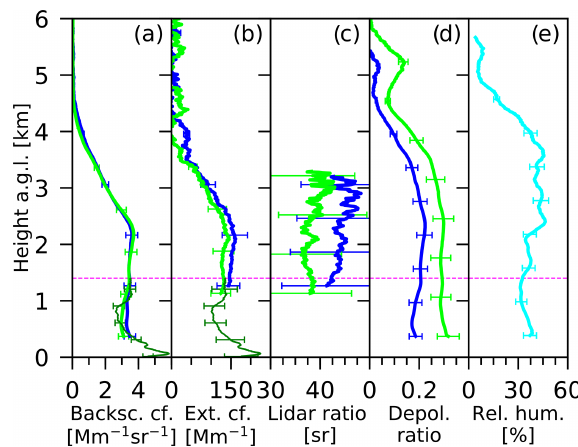
Figure 6. Overview of the basic lidar products obtained from the Dushanbe lidar observations. The Polly measurement was taken on 28 June 2016, 18:00–20:59UTC: (a) particle backscatter coefficient at 355nm (blue, 743m vertical smoothing length) and 532nm (dark green, 23m vertical smoothing, green, 743m vertical smoothing); (b) particle extinction coefficient at 355 (blue) and 532nm (green), 743m vertical smoothing, and 532nm particle extinction coefficient (dark green) calculated from the 532nm particle backscatter coeffi- cient (dark green in b ) and the 532nm lidar ratio at 1.4km (magenta dashed line indicates the 1.4km height); (c) lidar ratio at 355 (blue) and 532nm (green), 743m vertical smoothing; (d) particle linear depolarization ratio at 355 and 532nm; and (e) relative humidity. The 532nm AOT is computed from the extinction profile segments from the surface to 1.4km height (in b , dark green) and from 1.4 to 6.0km (in b , green). Error bars show the uncertainty in the profile